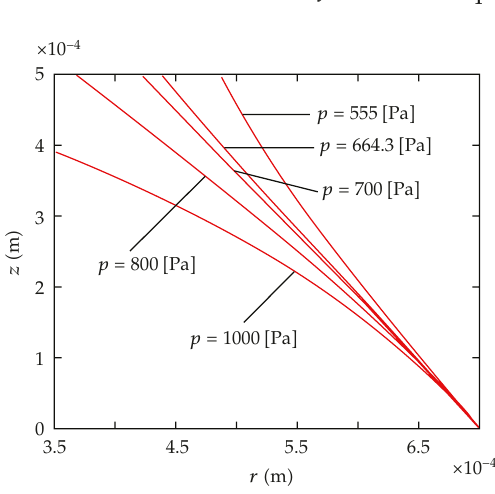
Figure 2: z versus r for p (cid:2) 555 , 664 . 3 , 700 , 900 , 1000 (cid:5) Pa (cid:7)